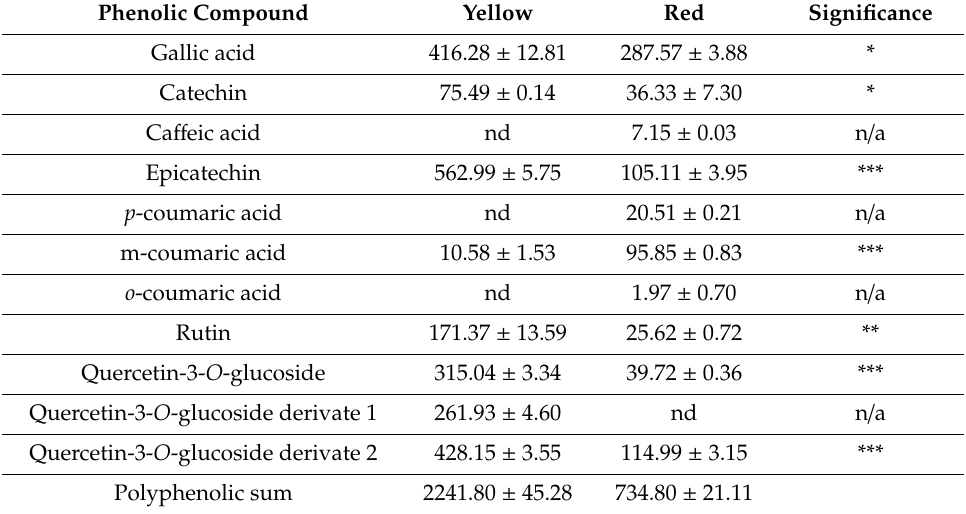
Table 4. Content ( µ g / g dry weight; mean ± standard error) of phenolic compounds of the two Tunisian P. canariensis varieties and results of variance